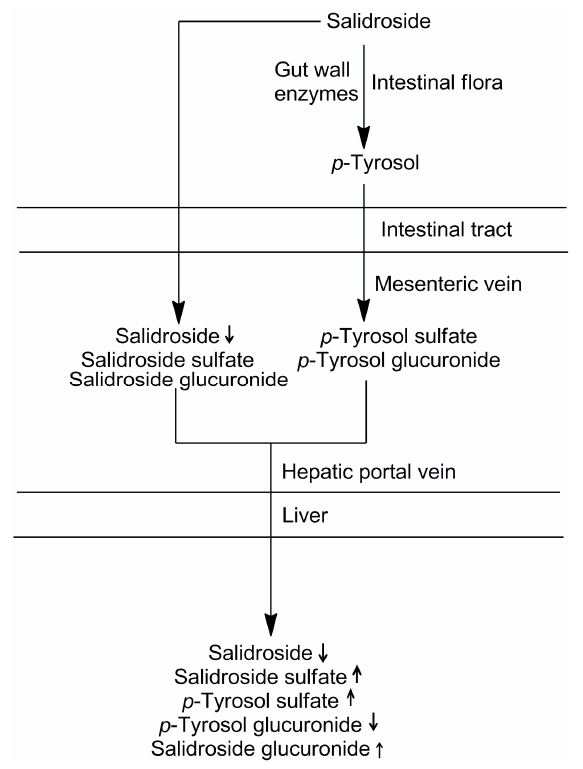
Figure 3. The sequential process of salidroside in the digestive system.